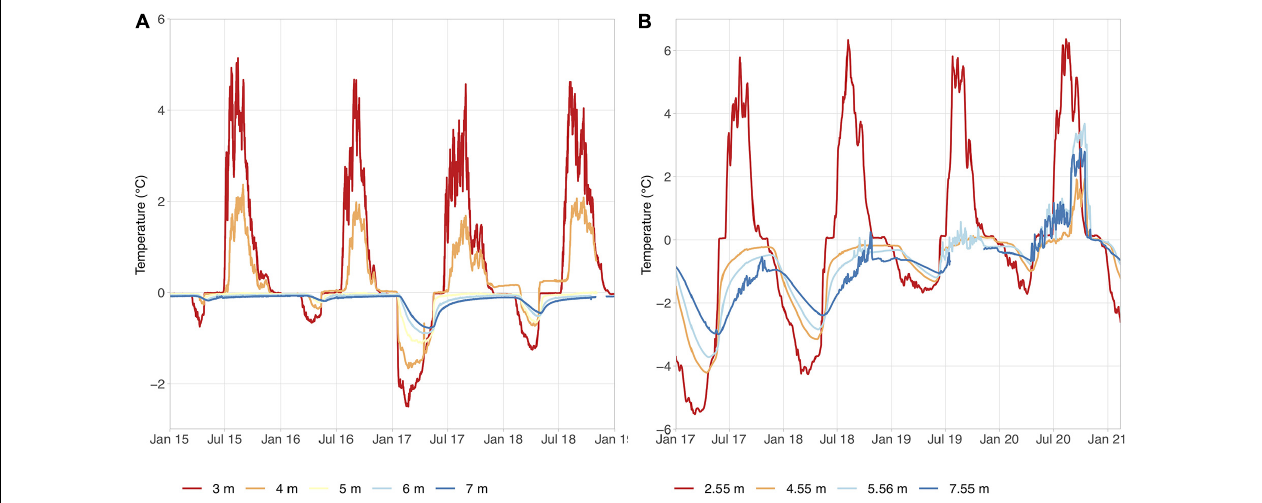
FIGURE 9 | Two examples of permafrost temperature time series with questionable data, which was detected during data control and flagged as doubtful or erroneous. (A) Sensor drift at a depth of 4 m, which can be detected based on the zero curtain and comparison with neighboring sensors. (B) The sensors at 4.55, 5.56, and 7.55 m depth increasingly show positive temperature peaks, which is a typical effect attributed to liquid water. It is difficult to distinguish whether they are caused by advection inside the borehole or moisture effects in the electronics. Data source: PERMOS.